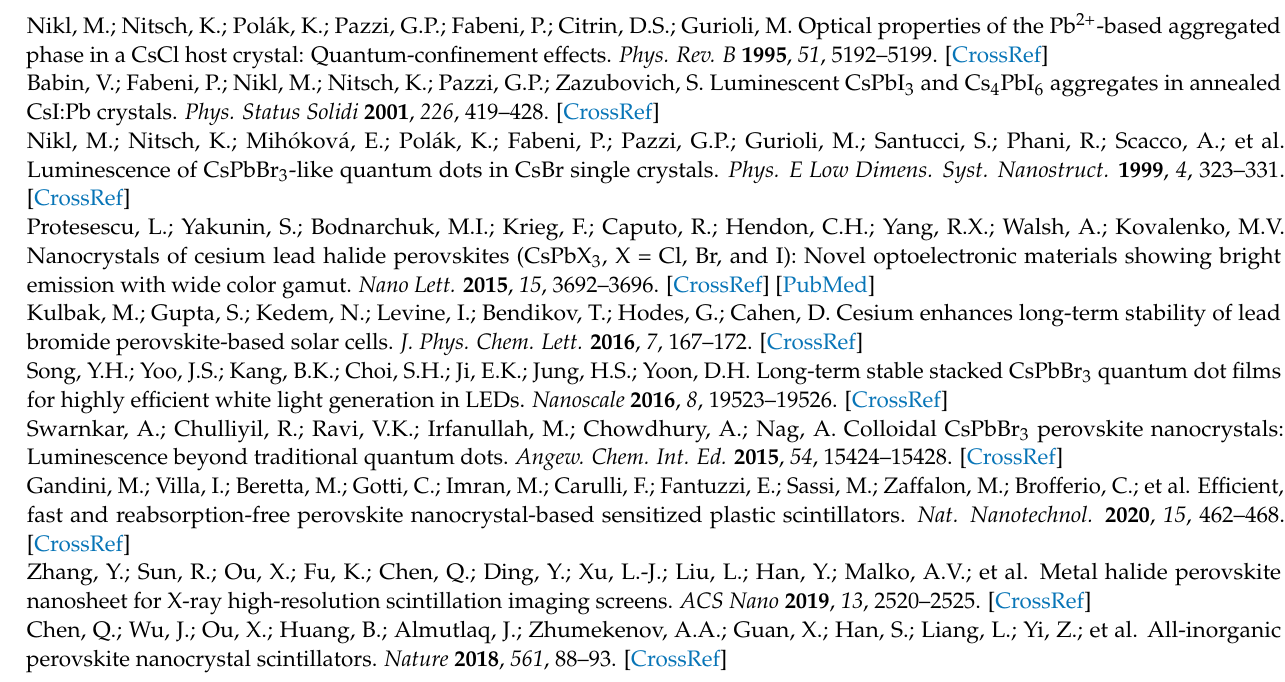
Figure S5: Comparison of PL of both samples excited by the 365 nm UV light. Reference [56] is cited in the supplementary